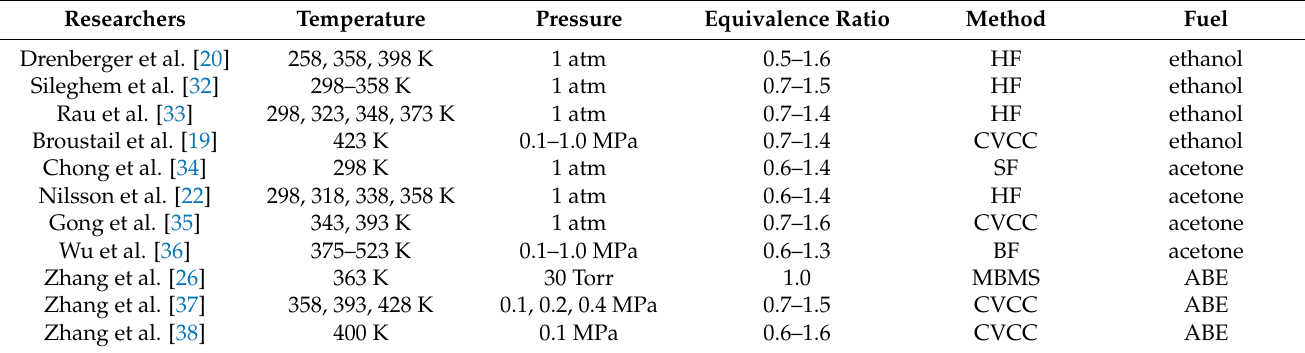
Table 1. Research on combustion characteristics of ethanol and acetone